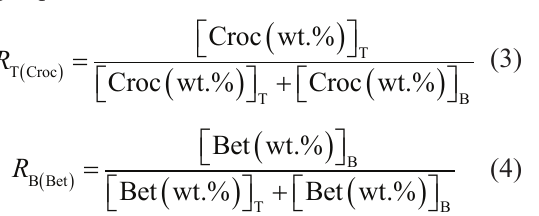
] Br (1) + Sorbitol (2) 4444